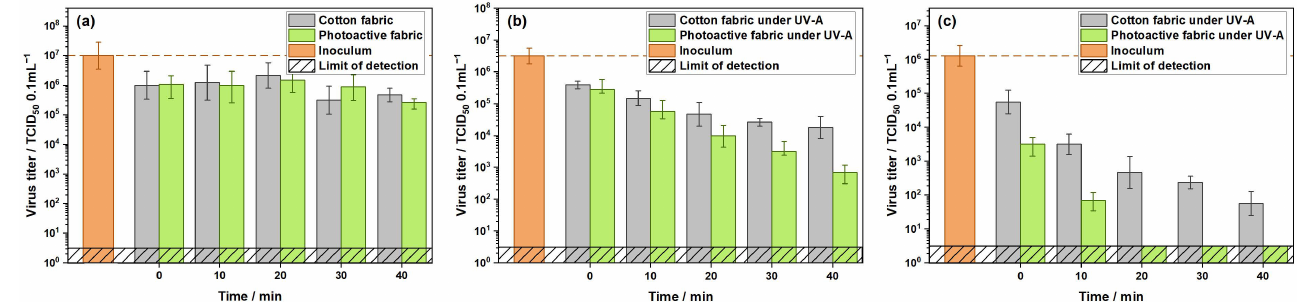
Figure 3. Dependence of virus titer on incubation time of contaminated cotton and photoactive fabrics without ( a ) and with ( b , c ) UV irradiation. Concentration of total protein in inoculum corresponds to 10 and 0.2 mg · mL − 1 for ( a , b ) and ( c ),